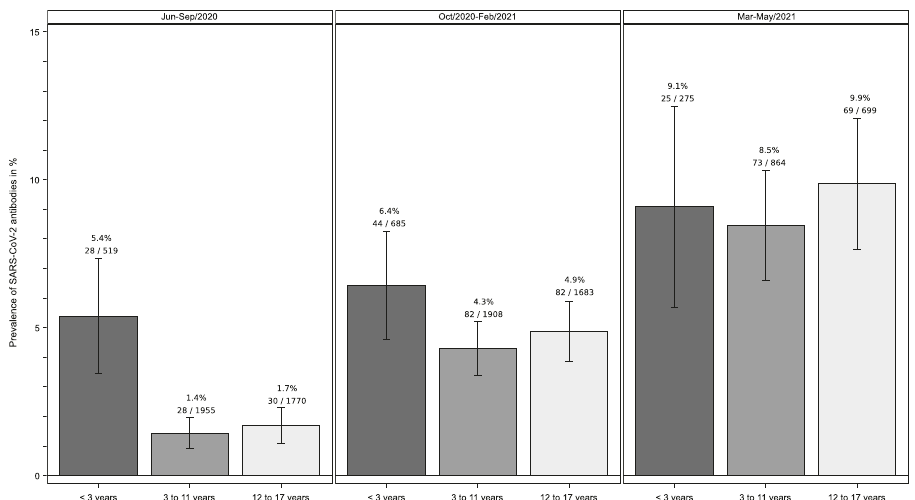
Fig. 3 Age group-speci fi c seroprevalence etimates in different phases of the COVID-19 pandemic in Germany. Prevalence of Severe Acute Respiratory Syndrome Coronavirus 2 (SARS-CoV-2) immunoglobulin G antibodies as determined by an enzyme-linked immunosorbent assay in blood samples from in total 10,358 paediatric study participants in the different stages of the COVID-19 pandemic in Germany strati fi ed by age category. The height of the boxes displays the respective point estimates of the prevalences and the wiskers indicates the upper and lower 95% con fi dence limits of these point estimates. Table 2 Ratio of children with previously reported positive SARS-CoV-2 test ǂ to all children with SARS-CoV-2 IgG antibodies, as determined by an Enzyme-Linked Immunosorbent Assay (ELISA), in different phases of the pandemic according to the date of study